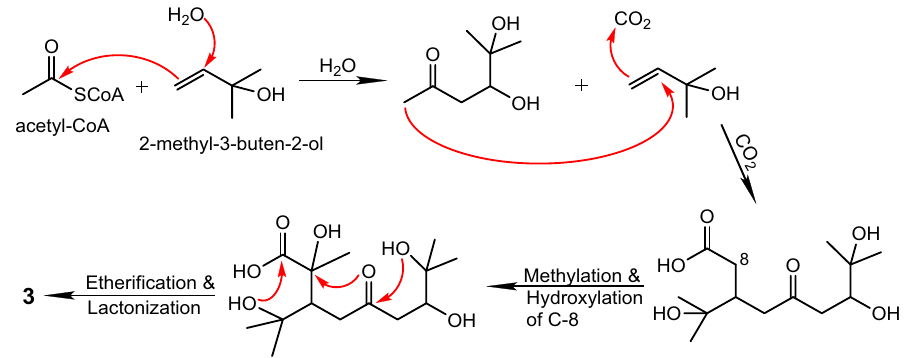
Figure 10. Putative biosynthetic pathway to 3 .